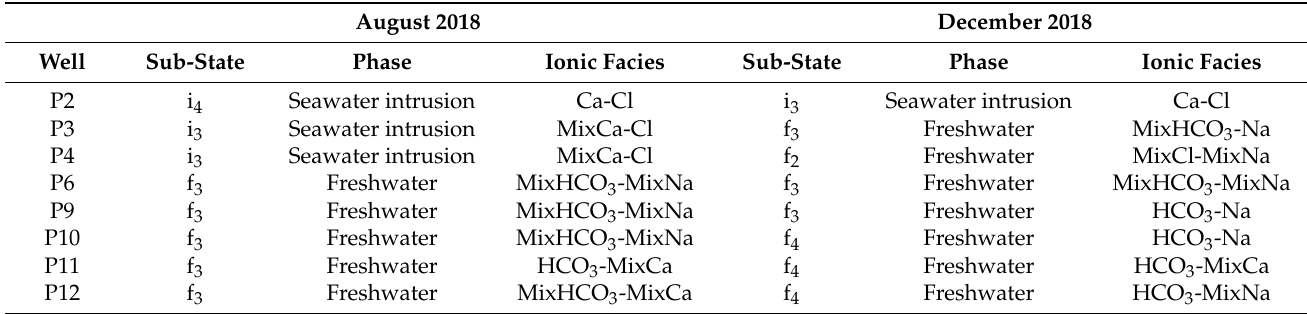
Table 3. Summary of the sub-state, phase, and ionic evolution of the groundwater of the Manglaralto river basin